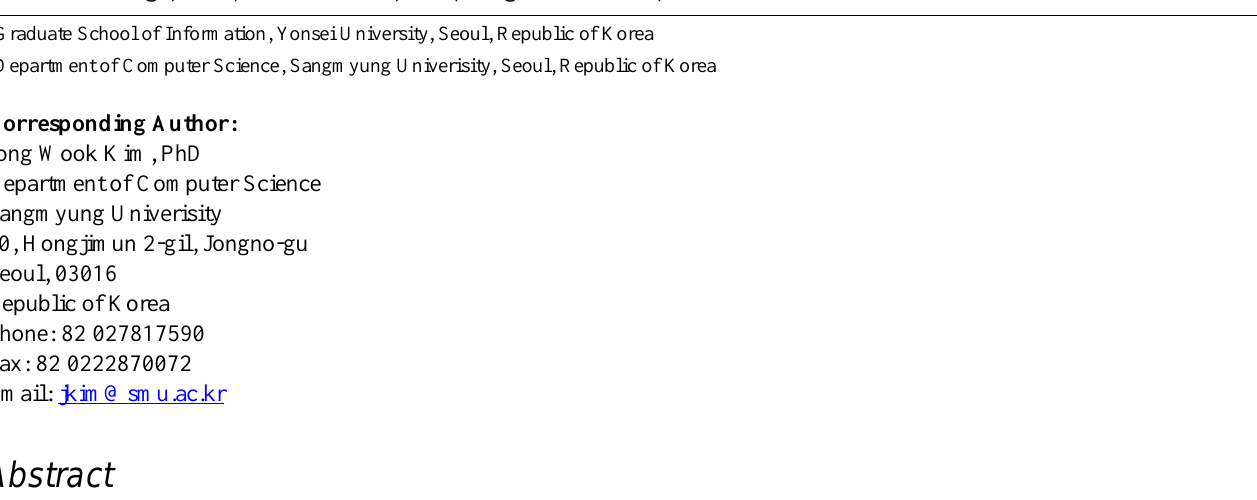
influenza; training data extraction; keyword; sorting; word embedding; Pearson correlation coefficient; long short-term memory; surveillance; infodemiology; infoveillance;